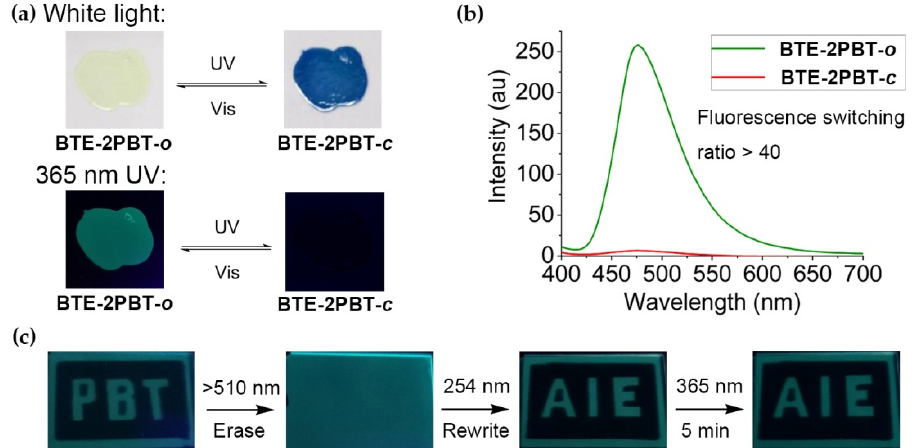
Figure 3. Photo-switchable AIE properties and application of BTE-2PBT triad. ( a ) Photographs of BTE-2PBT PMMA film illuminated with alternate 254 nm UV and >510 nm visible light taken under white light or 365 nm UV; ( b ) PL spectra of BTE-2PBT PMMA film at PSS illuminated with alternate 254 nm UV and >510 nm visible light ( λ ex = 365 nm); ( c ) Photoerasing, rewriting, and non-destructive reading of fluorescent images on BTE-2PBT PMMA film.